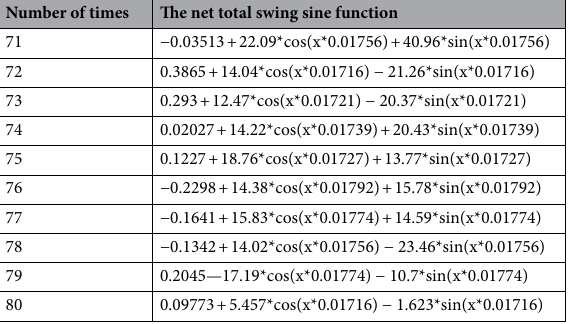
Table 4. Sine function of net full swing for 71–80